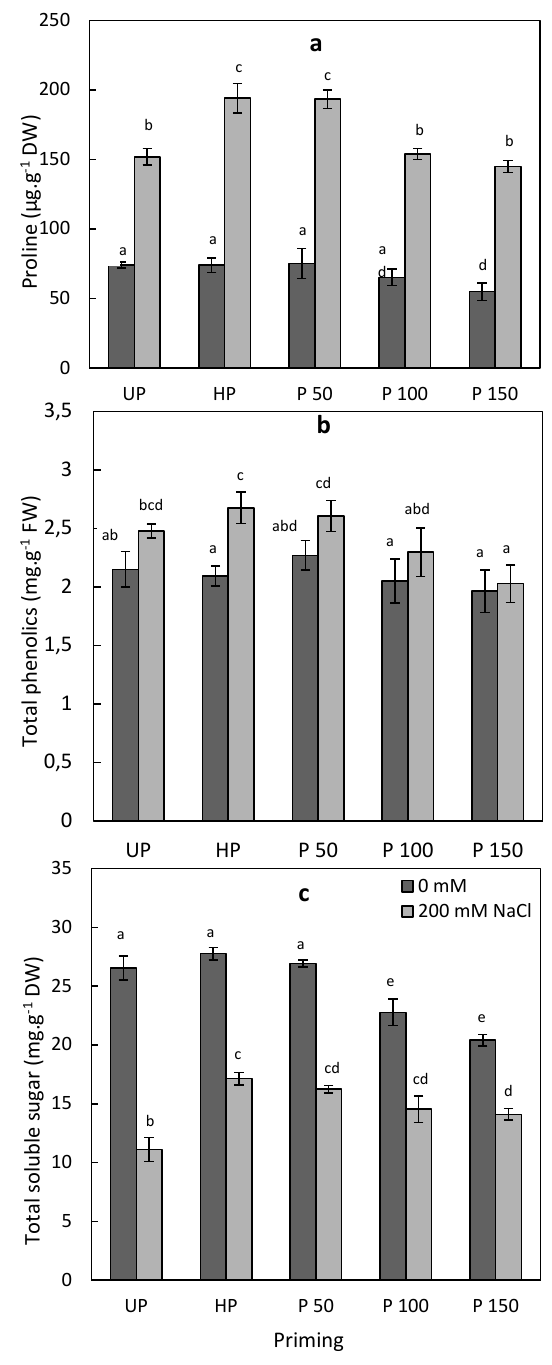
Fig. 4: Proline (a), total phenolic (b) and soluble sugar contents (c) of rice seedlings from unprimed and primed seeds grown under normal and high salinity. UP: unpriming, Hp: hydropriming, P 50: priming with 50 mM NaCl, P 100: priming with 100 mM NaCl and P 150: prim - ing with 150 mM NaCl. Bars with different letters are significantly different at p < 0.05 according to Duncan’s Multiple Range Test.